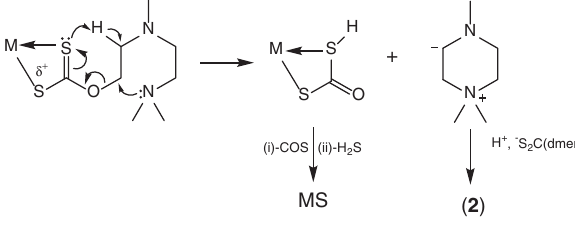
Scheme 1: Chugaev elimination and formation of compound 2 .